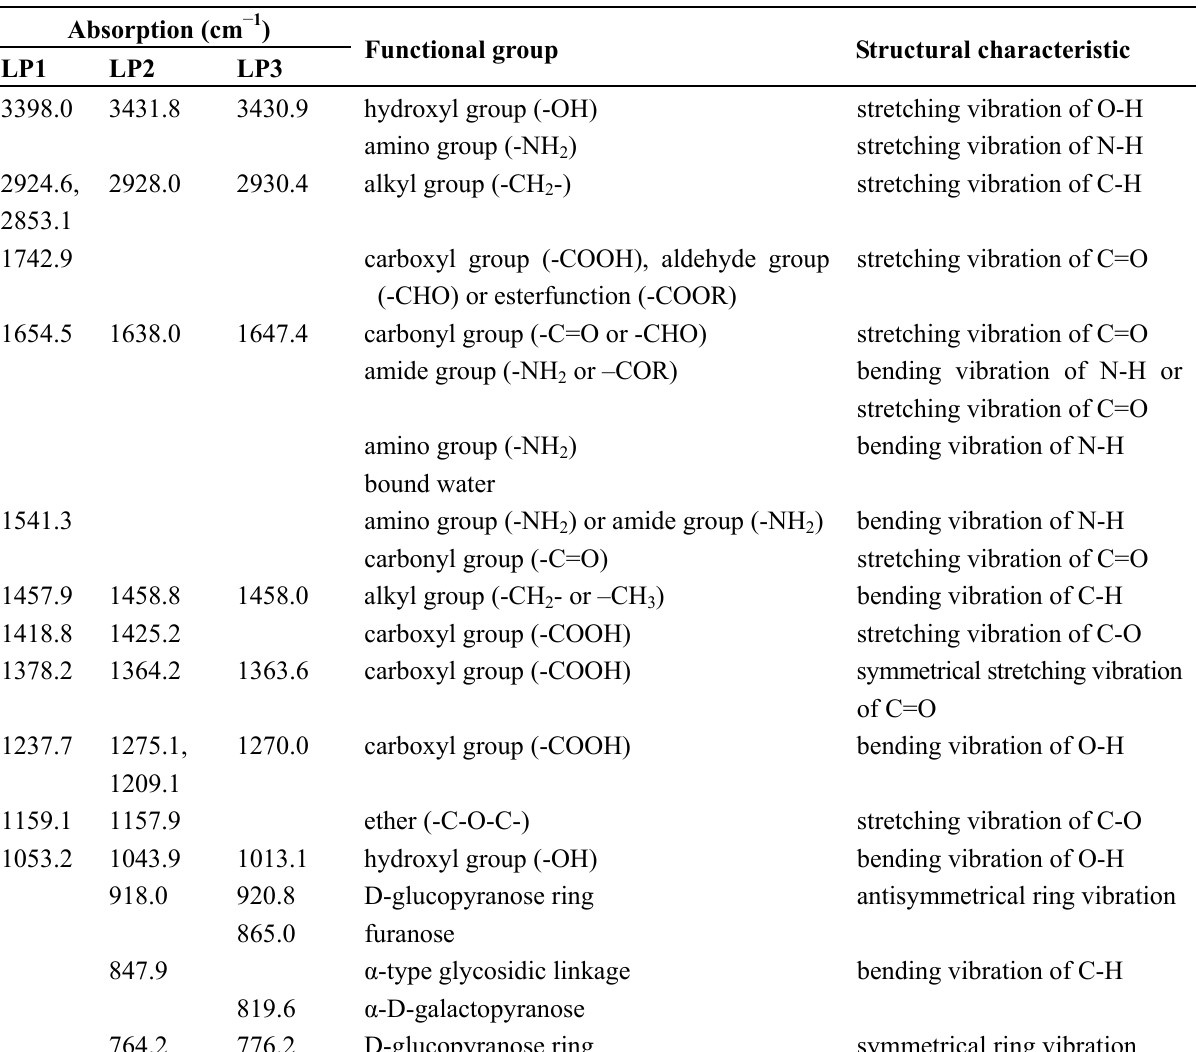
Table 2. FTIR spectrum analysis of functional groups of